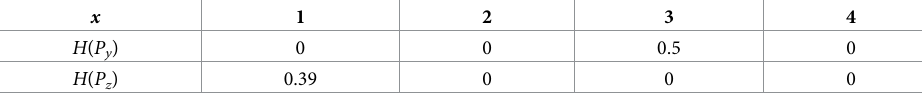
Table 1. Calculation example of symbolic